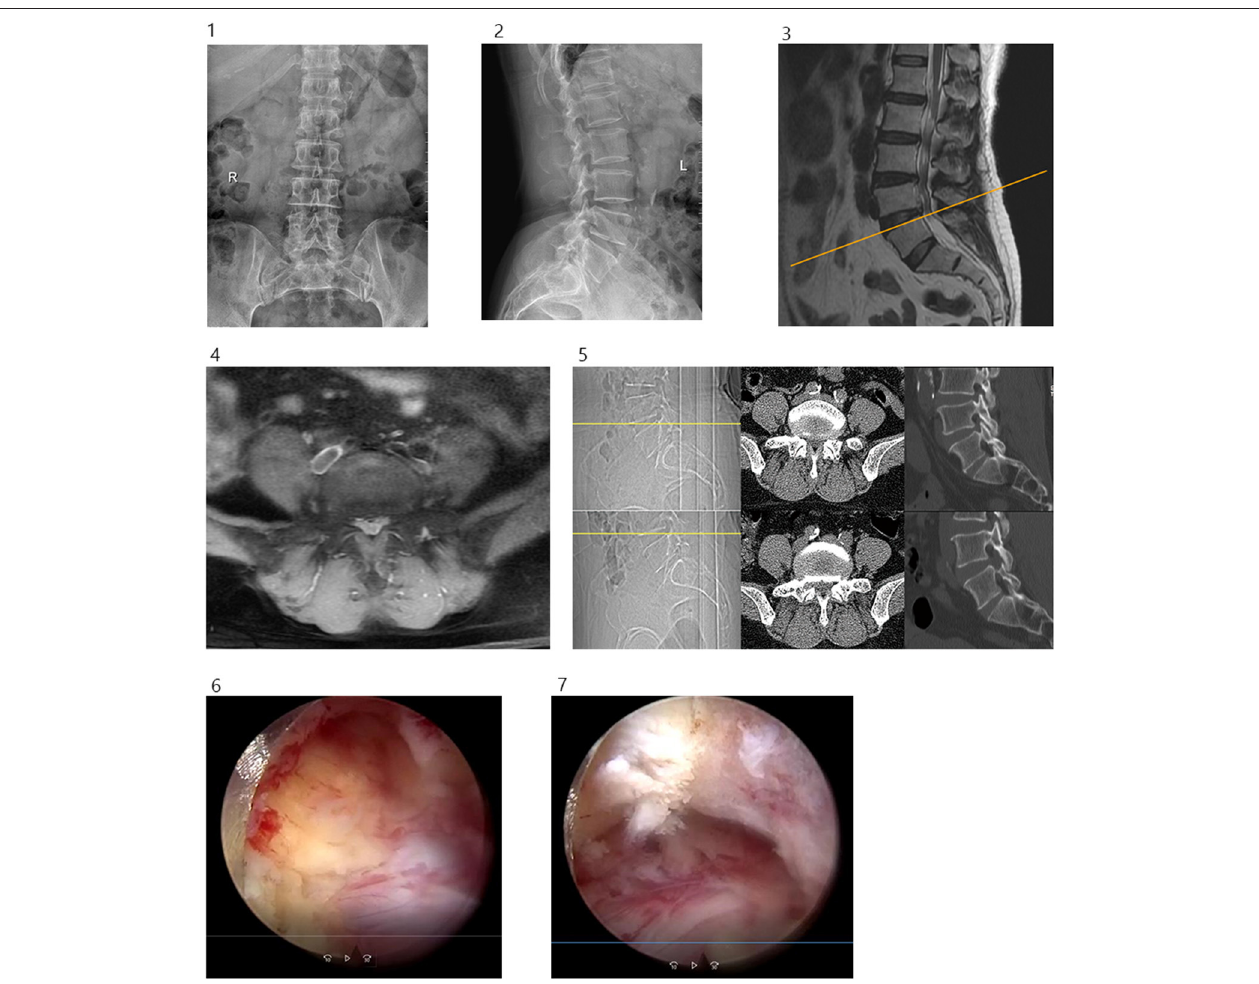
FIGURE 6 | (1) Preoperative lumbar spine anteroposterior projection. (2) Preoperative lumbar spine lateral position. (3 and 4) Preoperative lumbar spine MR showed lumbar 4/5 disc herniation with spinal stenosis. (5) Before and after operation, CT cross-sectional image showed lumbar 4/5 decompression of the right spinal canal, sagittal reconstruction showed partial ventral resection of the superior articular process of L5, partial resection of the upper edge of the vertebral pedicle of L5. (6) Ventral partial resection of the superior articular process of L5 was observed under endoscopy. (7) Partial resection of the upper edge of the pedicle of L5 was observed under